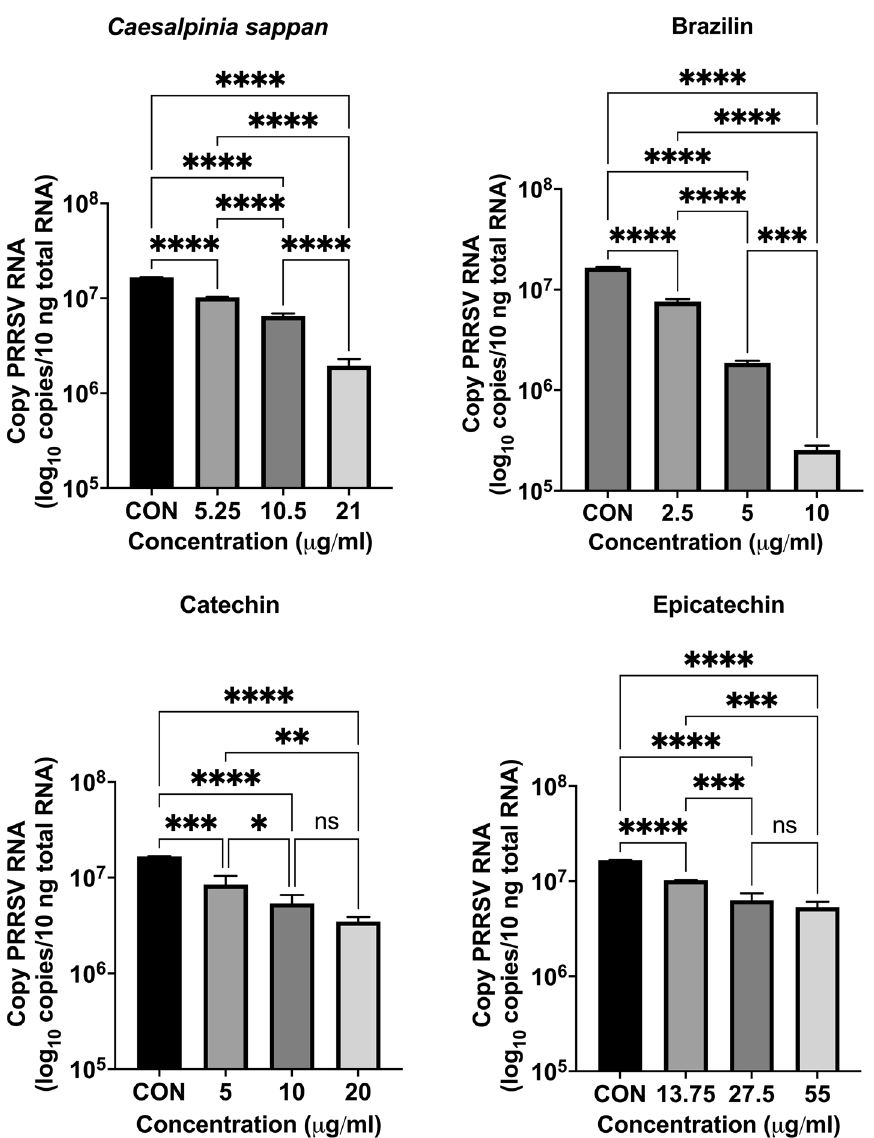
Figure 8. Intracellular PRRSV RNA release evaluated by real-time PCR of MARC-145 cells treated with Caesalpinia sappan extract, brazilin, catechin, and epicatechin combined with PRRSV 1 h prior to MARC-145 cells inoculation.The data (mean ± SD) are indicative of three independent replicates. To compare the means of samples with differing concentrations, Tukey’s test was used to assess statistical significance. CON, control; ns, not significant; * P < 0.05; ** P < 0.01; *** P < 0.001; **** P <